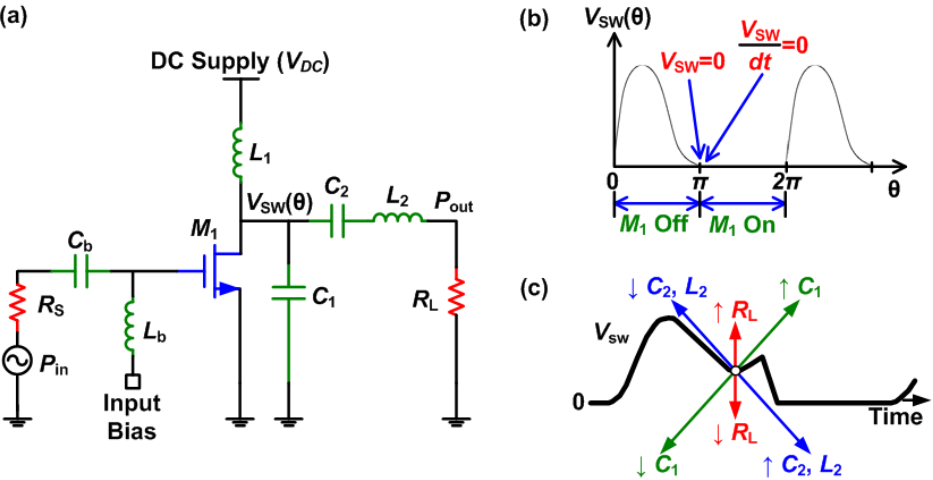
Figure 12. (a) Basic schematic of a class-E power amplifier. (b) The drain voltage waveform of an ideal class-E amplifier. (c) The effects of adjusting the output network components of a class-E amplifier